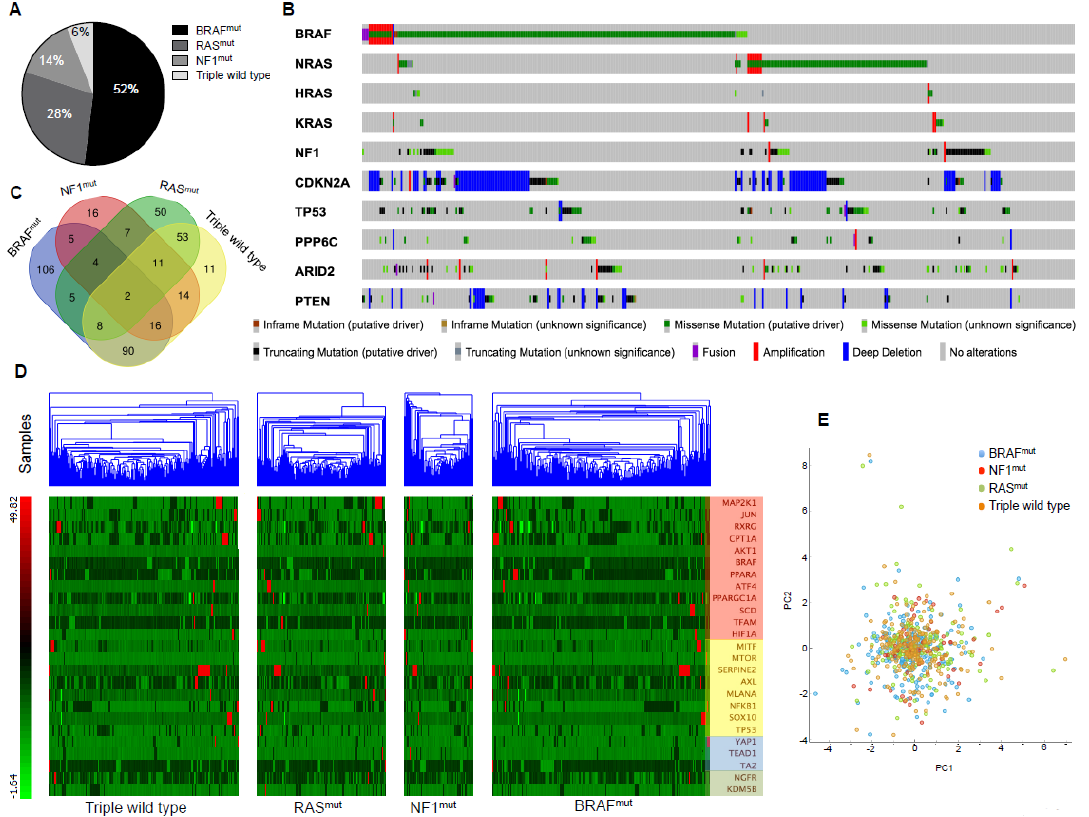
Figure 4. Melanoma stem cell signature (“MSCsign”) expression levels evaluated according to Figure 4 skin cutaneous melanoma mutational subtypes. ( A ) Cake graph representing the most common mutational subsets of metastatic melanoma. ( B ) OncoPrint evaluation of distinct genomic alterations. ( C ) Venn diagrams showing the overlapping of the patients belonging to the four mutational subtypes. ( D ) Heat-maps of the expression levels of the 25 genes of “MSCsign” clustered according to the mutational subsets. ( E ) Principal component analysis performed on the expression levels of “MSCsign” in the four mutational subtypes. Data from https: // www.cbioportal.org /